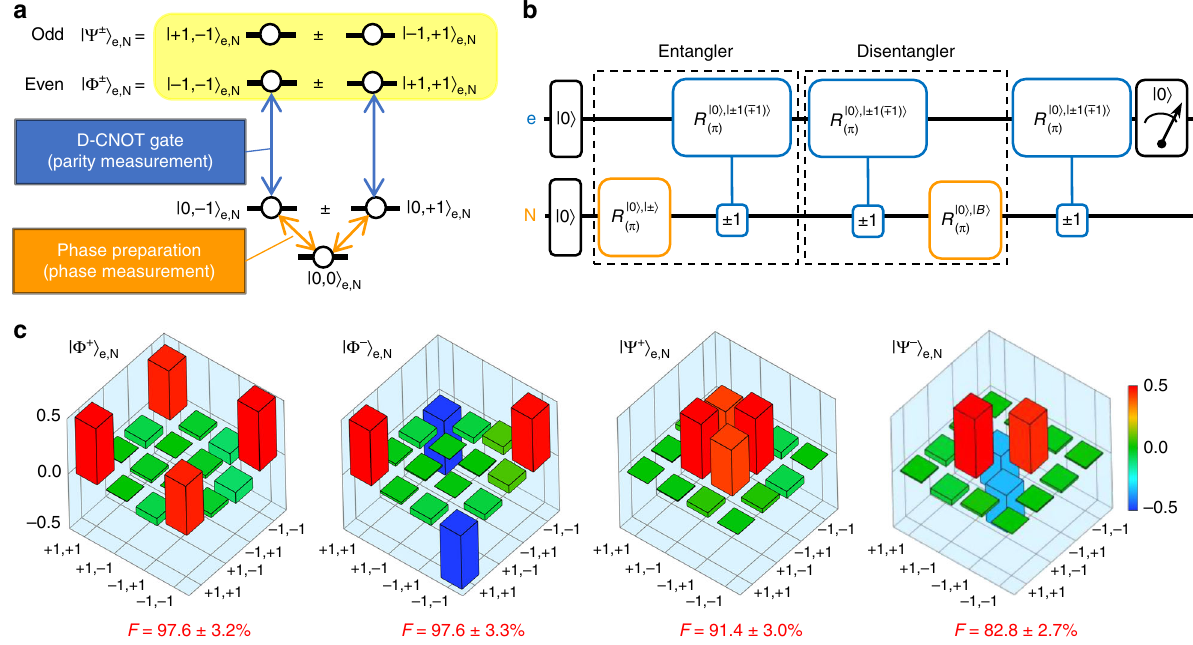
F = 97.6 ± 3.2% Fig. 9 Preparation and measurement of the geometric entangled states. a The schematic energy-level diagram for the electron − nuclear composite system to show the scheme of the two-qubit holonomic gate. The |±1 〉 e and |±1 〉 N states are split by 4.336 MHz by the hyper fi ne interaction to allow frequency- based detection of parity in the entangled state whether even Φ ± j i or odd Ψ ± j i with the D-CNOT gate, while the selection of radiowave polarisation e ; N e ; N allows phase detection. b The quantum circuit of the two-qubit state tomography measurement. The two π pulses for the 14 N nuclear spin correspond to the Hadamard gates used for the conventional entangler scheme. c The real part of the density matrix of the Bell states reconstructed by the two-qubit quantum state tomography. The F indicates fi delity and the bars indicate the values of the matrix